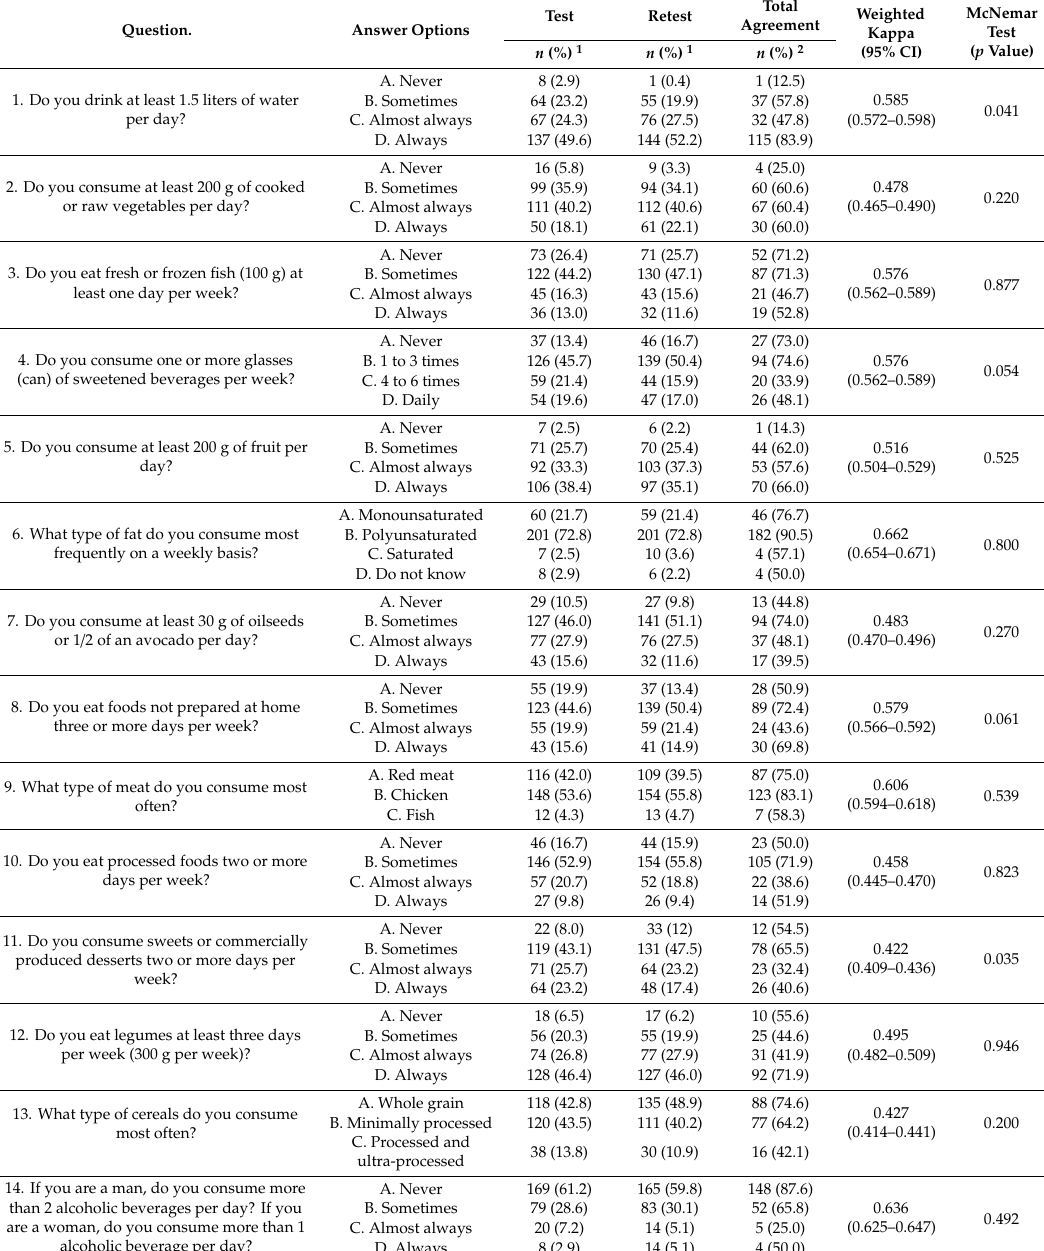
Table 3. Concordance in the questions in the Mini-ECCA v.2.